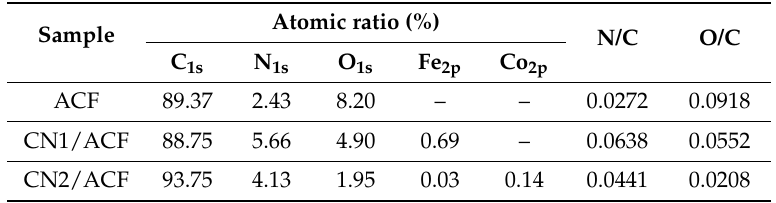
Table 1. Surface atomic ratios of the samples from XPS analysis.